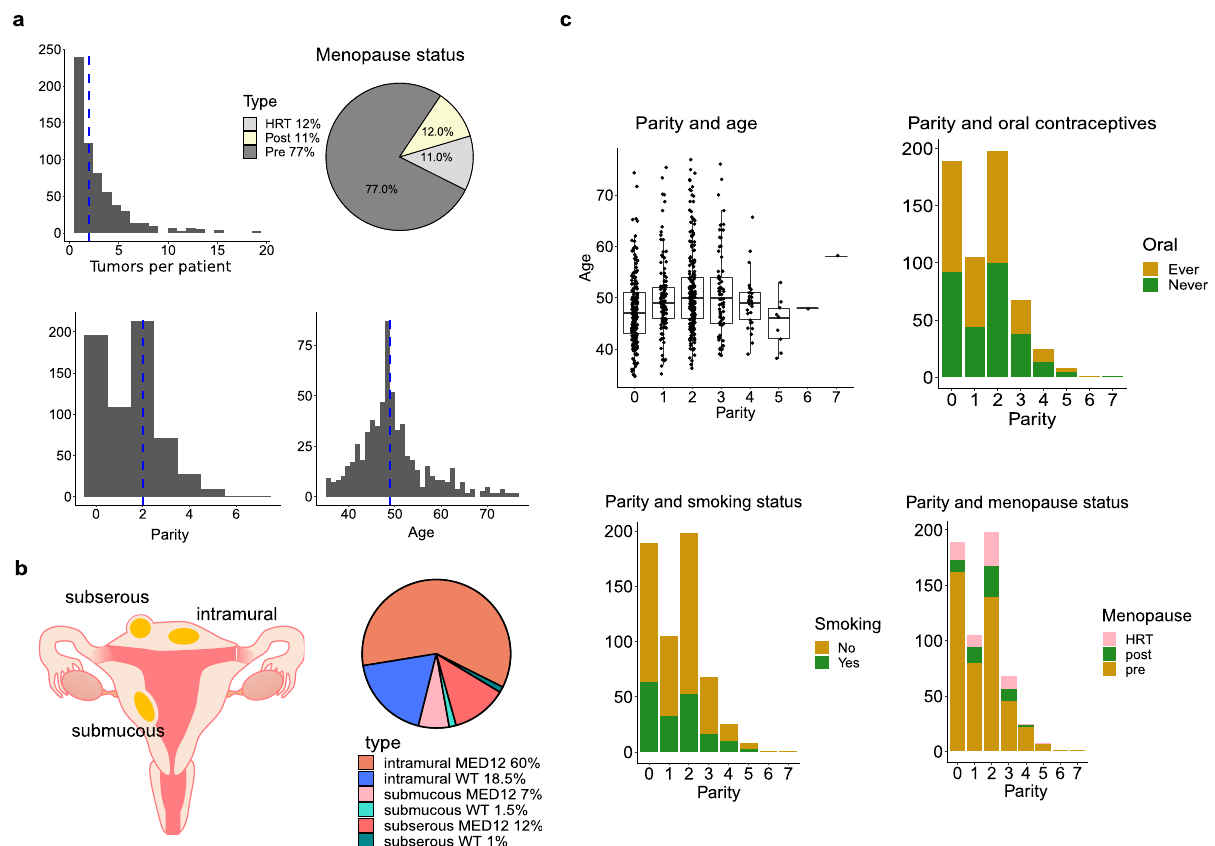
Fig. 1 Patient characteristics and tumor location. a Patient characteristics ( N = 628). The distribution of the number of tumors per patient, parity, the age of the patients, and menopause status. Median is shown by blue vertical line. b Intramural, subserous, and submucous locations of uterine leiomyomas (ULs) ( N = 1451). The majority of the tumors are intramural, but MED12 mutated tumors are associated with subserous location. c On the top left, age at hysterectomy strati fi ed by parity. The y -axis is in years. Boxplots show the median and the fi rst and third quartiles. Error bars extend up to 1.5 IQR above the quartiles. The number of patients in each class is: parity 0 = 196, 1 = 108, 2 = 213, 3 = 71, 4 = 28, 5 = 9, 6 = 1, 7 = 1. On the bottom left, the number of patients with a history of ever smoking (yes/no) strati fi ed by parity. On the top right, the number of patients with combined oral contraceptives use (ever/ never) strati fi ed by parity. On the bottom right, the number of pre-menopausal, post-menopausal patients and patients with hormonal replacement therapy (HRT). Source data are